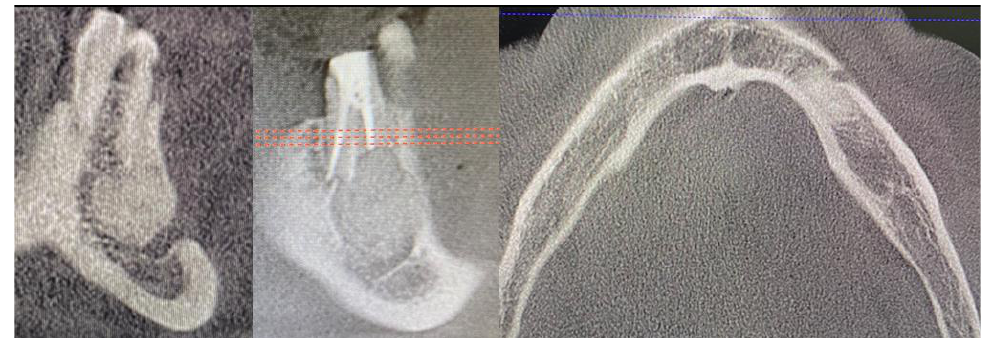
Figure 8. CBCT just after the cyst removal. CBCT presented with the following scans, from the left: coronal, sagittal, and axial. A close proximity to the left mental nerve is seen. Some image disturbances from 3D evaluation are visible.